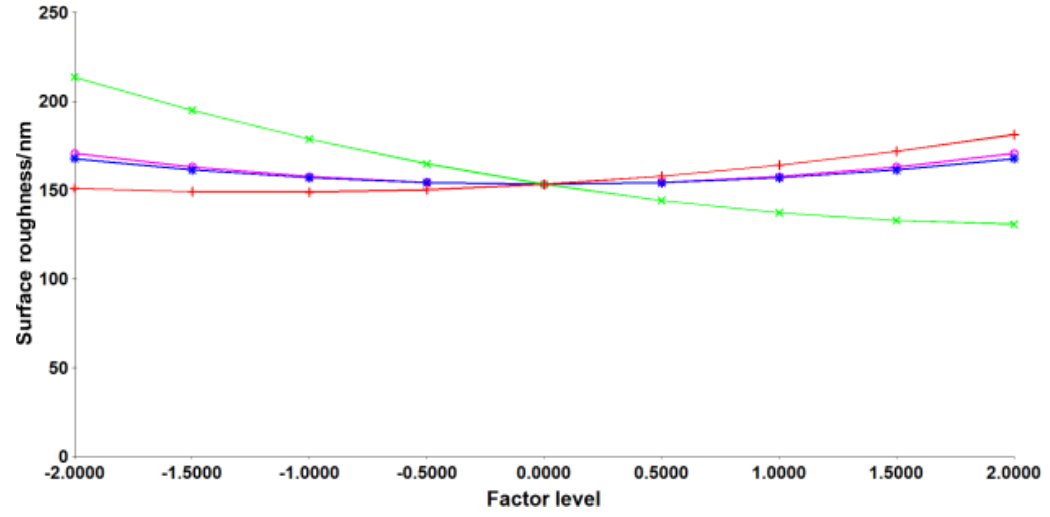
(1) Analysis of the influence of grinding depth on surface